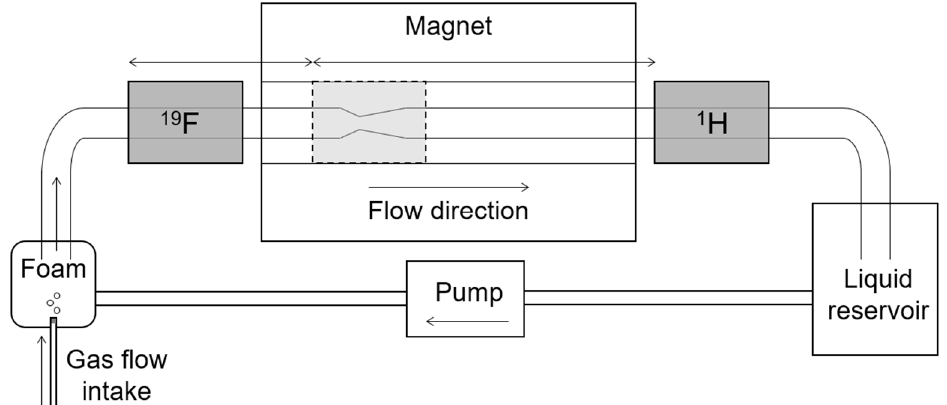
Figure 3. Schematic of the flow apparatus. Foam was created by bubbling C 4 F 8 gas through a liquid solution and flowed through a pipe placed in the magnet. A constriction in the pipe was the region of interest. Fluorine signal (gas phase) was measured by inserting the 19 F RF probe and removing the 1 H RF probe. Hydrogen signal (liquid phase) was measured by inserting the 1 H RF probe and removing the 19 F probe. The shuttling of probes was accomplished without interrupting the foam flow.